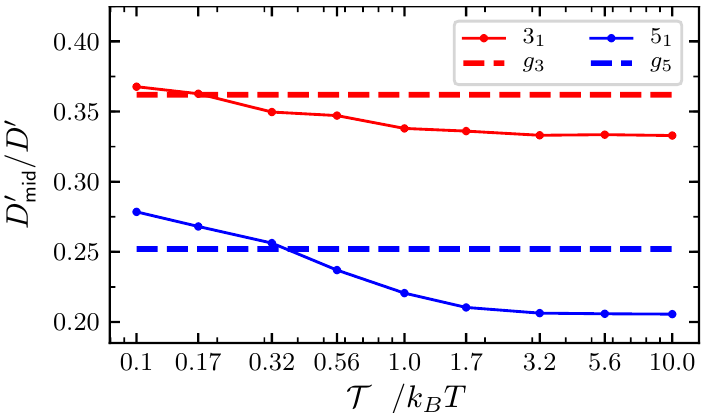
Figure A3. Analysis of the diffusion coefficient D (cid:48) Equation (2) on an infinite support. Full lines: g n = D (cid:48) n = n k = 3 for the trefoil and n = n k = 5 for the 5 1 knot. Dashed lines represent the corresponding value in the free diffusive case ( f (cid:48) =